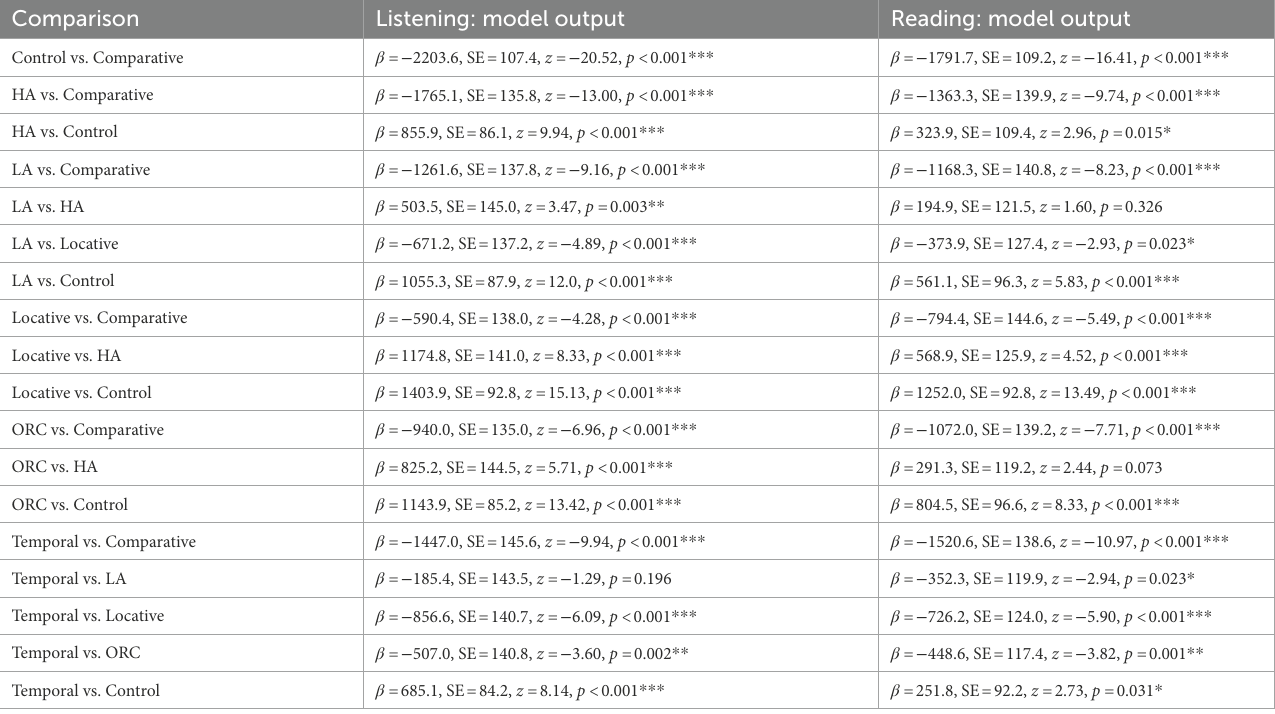
TABLE 9 Significant model outputs for answering time analysis in Experiment 2.